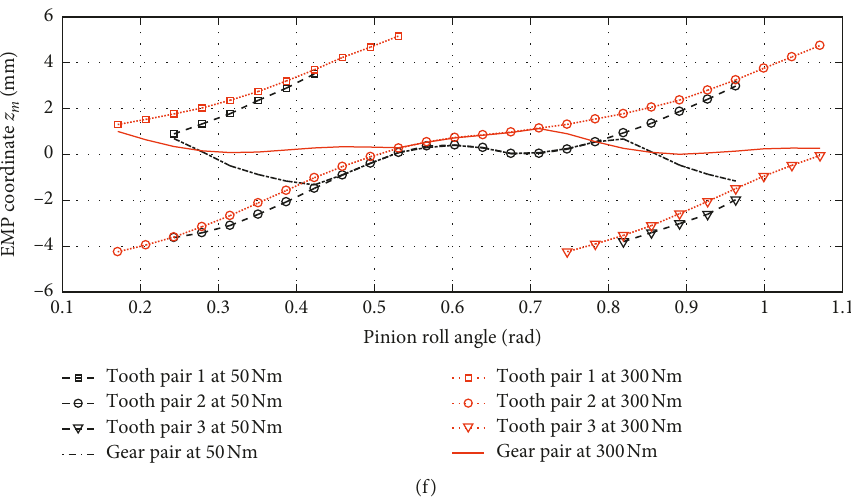
Figure 7: Comparison of time-varying line of action directional cosines (a–c) and effective mesh point coordinates (d–f) between the MMTP and the MMGP at 50Nm and 300Nm torque loads.